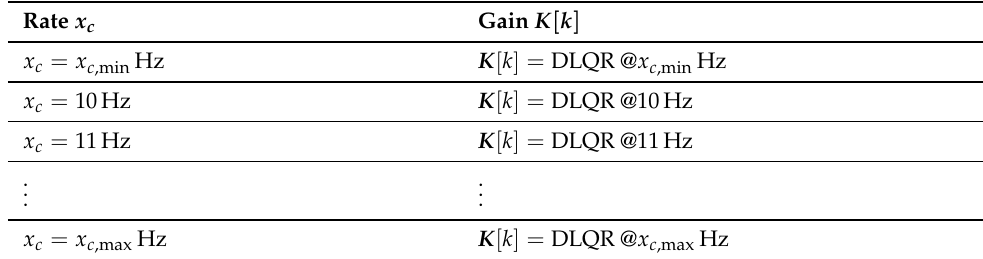
Table 1. Scheduled Gains at different sampling rates